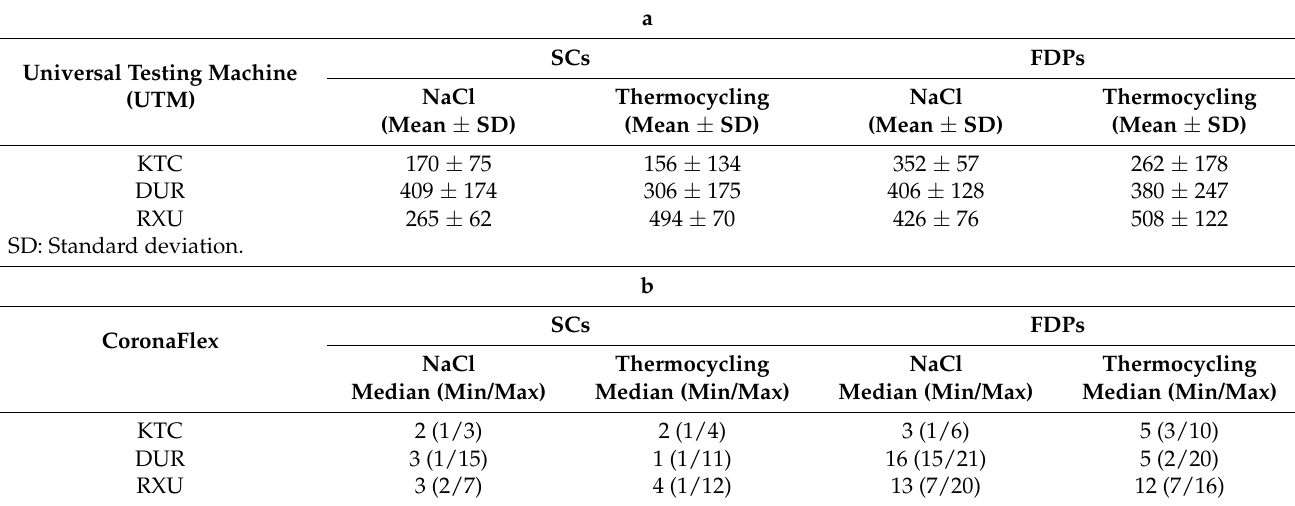
Table 1. (a) Mean retention forces to remove the specimens using UTM (in Newton). (b) Median number of attempts to remove the specimens with Coronaflex (in